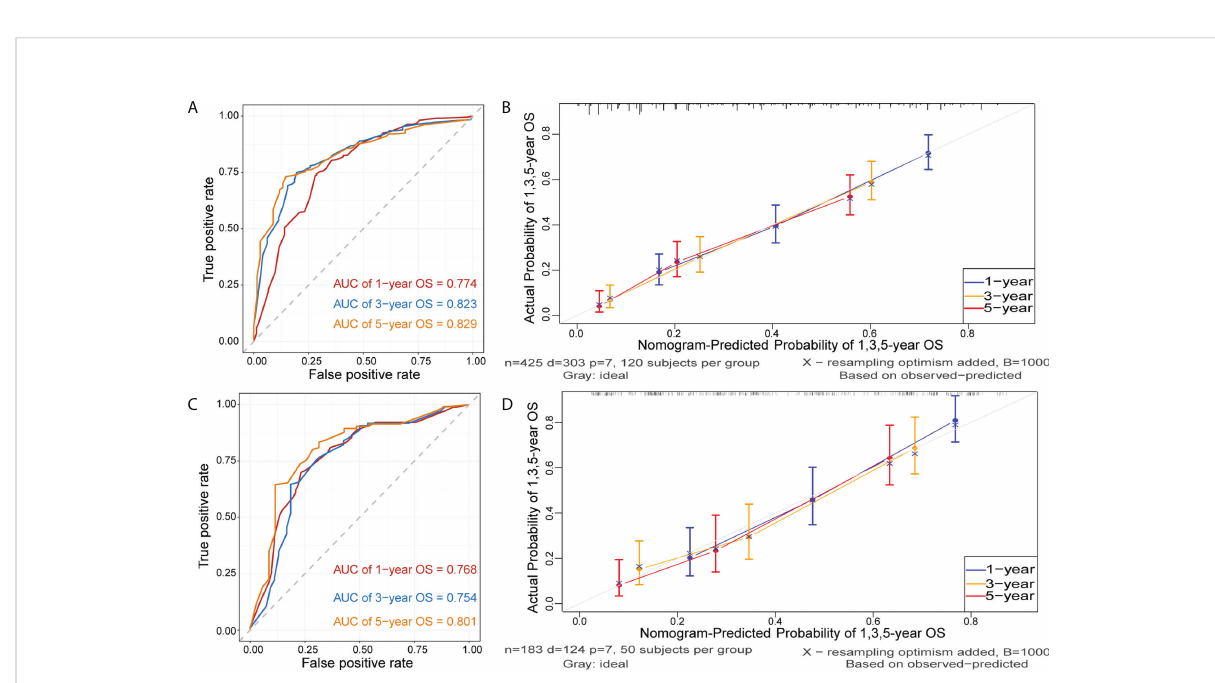
FIGURE 5 Receiver operating characteristic (ROC) and calibration curves of the nomogram for OS. ROC curves were plotted to evaluate the performance of the model to discriminate between patients with different survival outcomes (alive or dead), quanti fi ed by calculating the area under the ROC curve (AUC). The AUC of nomogram for predicting 1-, 3-, and 5-year OS were 0.774, 0,823 and 0.829 in the training cohort (A) and 0.768, 0.754, and 0.801 in the validation cohort (C) . Calibration curves were plotted to evaluate the accuracy of the nomogram model. The horizontal axis represents the survival rate predicted by the model, and the vertical axis represents the actual survival rate. The diagonal line represents the ideal situation where the predicted and actual survival rates consist, and the blue, orange, and red lines represent the model ’ s predicted and actual survival rates for 1-year, 3-year, and 5-year OS, respectively. Calibration curves of the nomogram for predicting 1-, 3-, and 5-year OS in the training cohort (B) and in the validation cohort (D)